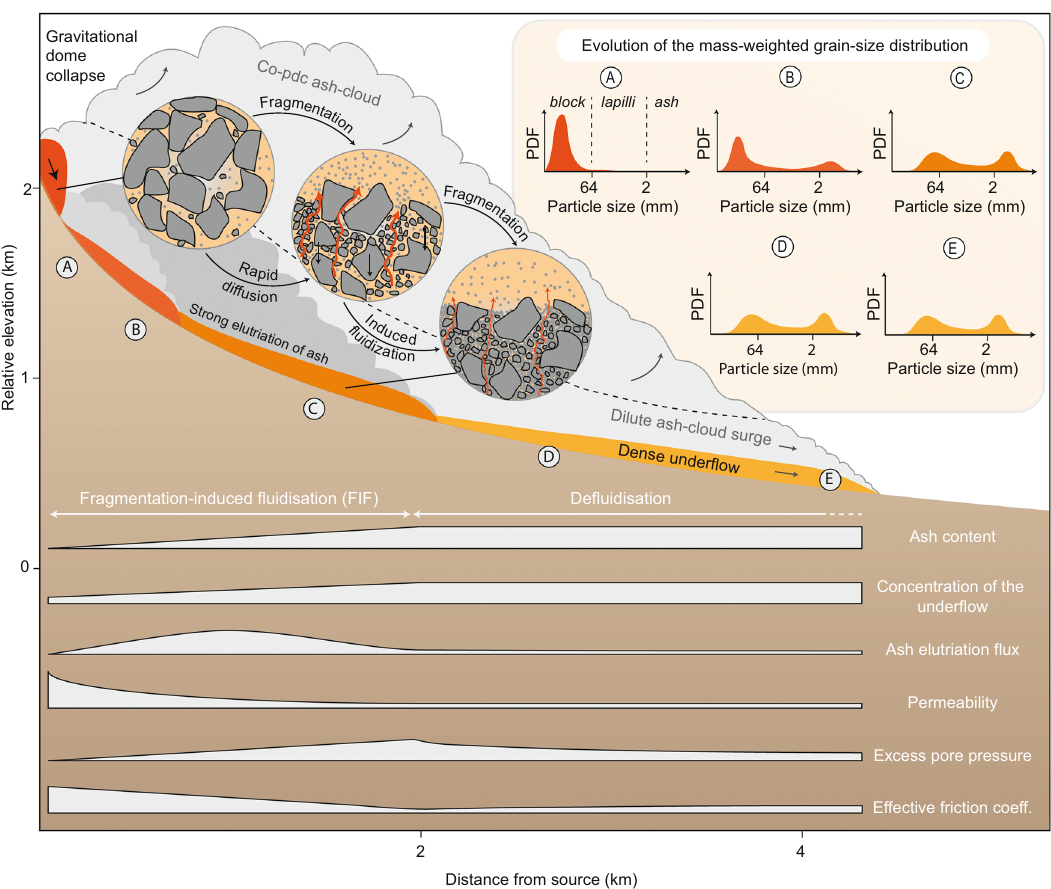
Fig. 5| Thefragmentation-induced fl uidisationofpyroclasticdensitycurrents. Conceptual summary sketch describing the process by which the evolution of the grain-size distribution transported induces compressibility effects in the granular avalanche, which in turn yields partially fl uidisation and subsequently lowers the